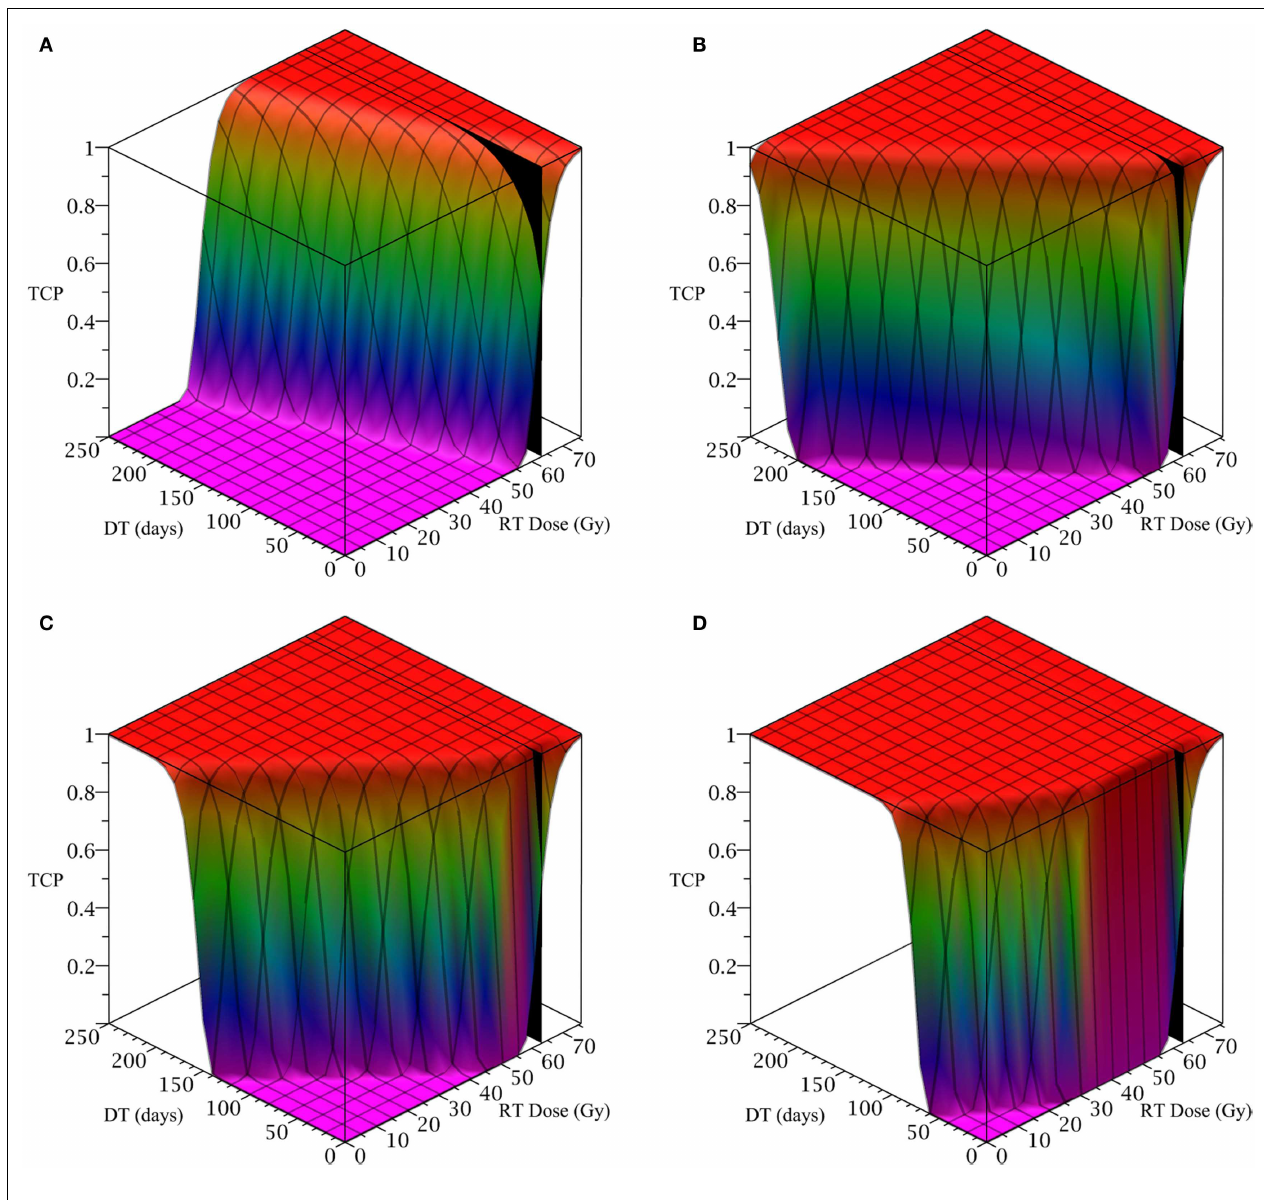
Simulations with CSC sensitivity to DT, ψ = 0 . 5.Thus, the probability of CSC self-renewal, p > 0 . 40. (B) Simulations with ψ = 2.Thus, p > 0 . 30. (C) Simulations with ψ = 5.Thus, p > 0 . 25. (D) Simulations with ψ = 50. Thus, p > 0 .